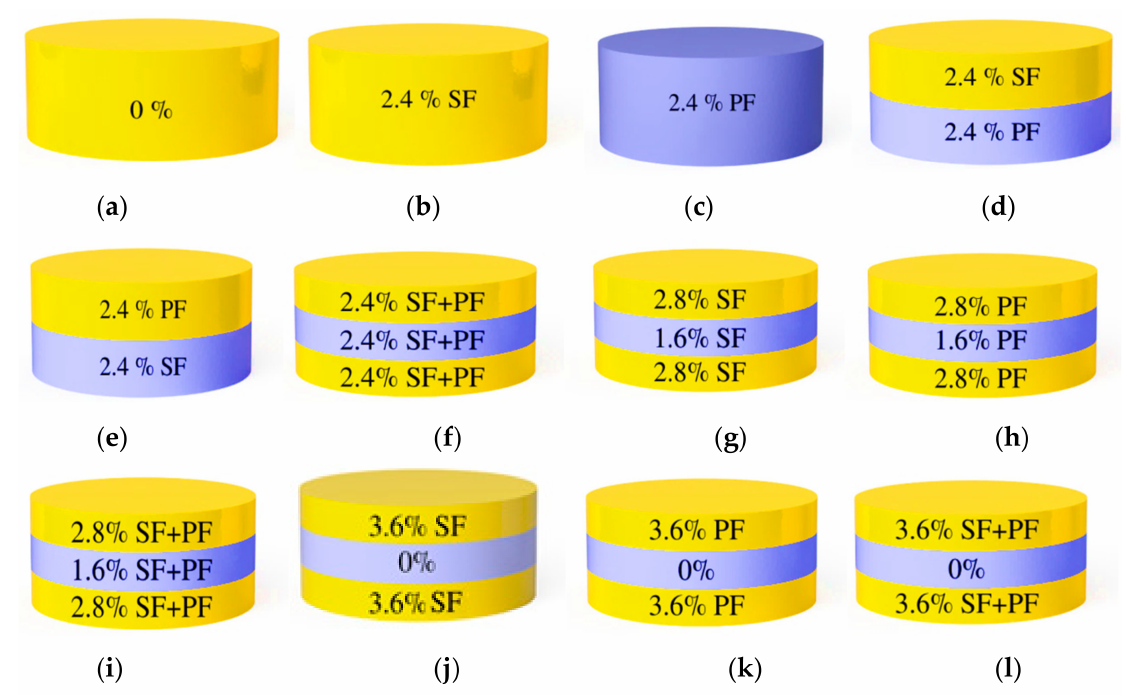
Figure 4. Details of fibre content used in the layers. ( a ) PAC, ( b ) S-SF, ( c ) S-PF, ( d ) D-SF-PF, ( e ) D-PF-SF, ( f ) T-FG1, ( g ) T-FG2, ( h ) T-FG3, ( i ) T-FG4, ( j ) T-FG5, ( k ) T-FG6, ( l )